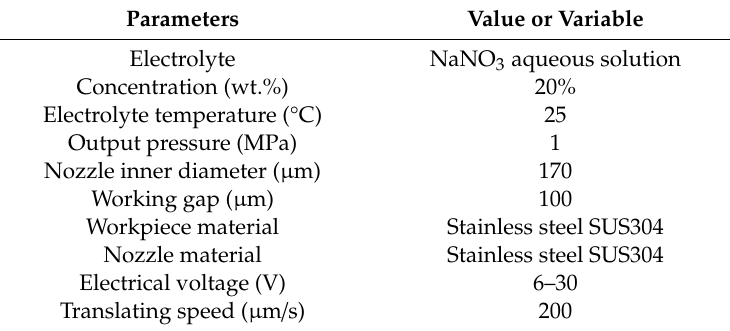
Table 4. Experimental